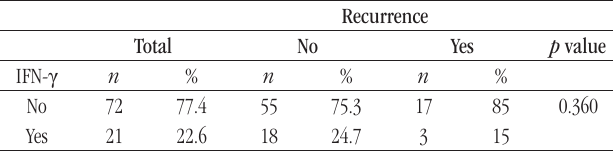
table 3 – Analysis of IFN- γ immunoexpression and its relationship with the rate of tumor recurrence in patients with meningioma